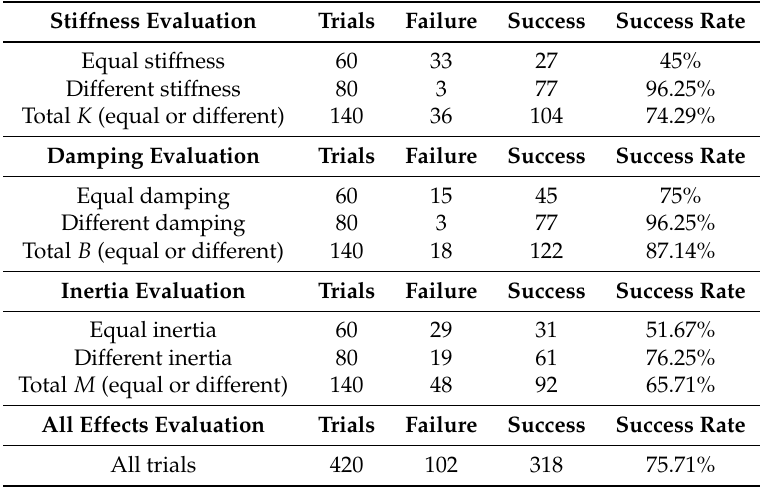
Table 3. Experimental results from the